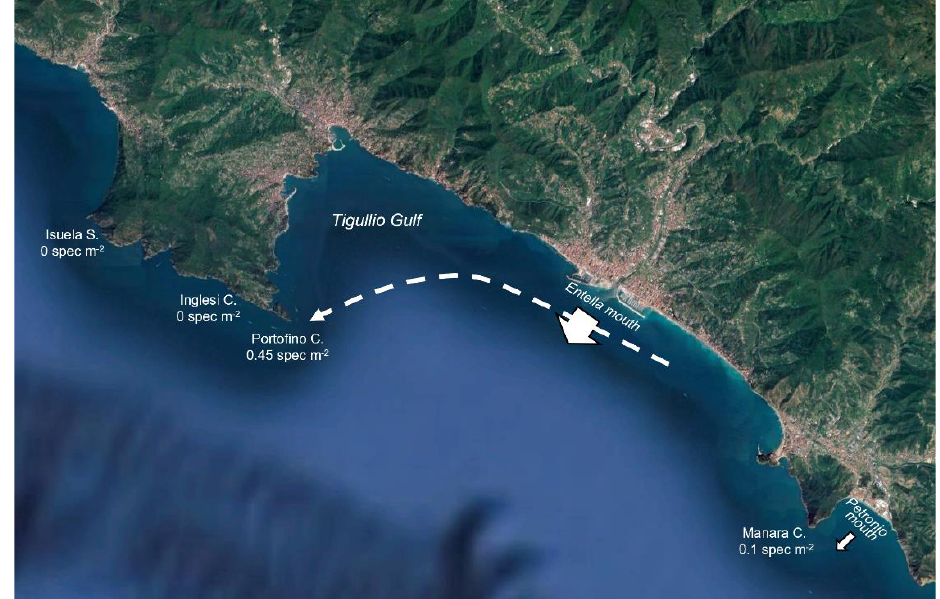
Figure 9. Map of the Tigullio Gulf, the zone characterized by the highest recorded densities of Astrospartus mediterraneus . The arrows indicate the inputs of the two main rivers of the area (Entella and Petronio). The arrow thickness is proportional to the mean flow rates. The dashed line represents the direction of the main current in the Gulf.